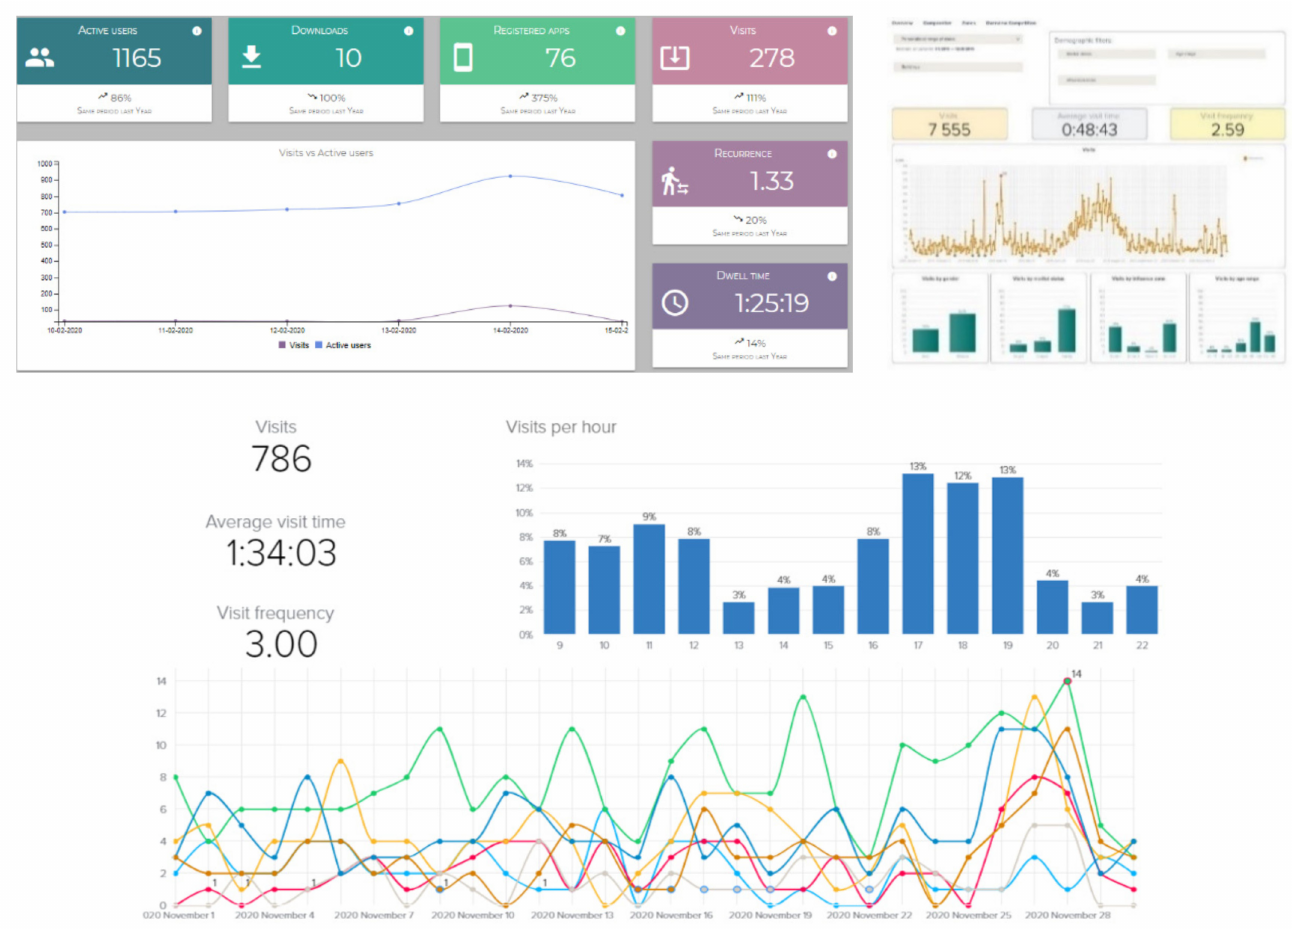
Figure 2. Examples of the KPI panel for marketing purposes in a